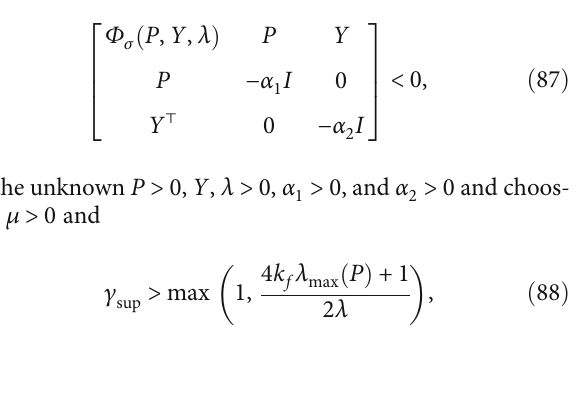
Figure 2: Measurement, state variables, estimates, residuals, and γ ð t Þ for x ð 0 Þ = ð 0,0,0 : 01 Þ and ̂ x ð 0 Þ = ð 1, 1, 1 Þ in a noisy simulation with ð t Þ zero-mean uniform random noise in [-0.1,0.1] and w w 1 and, using γ ð t Þ ≥ γ under condition (70) and j ̂ e j ≤ inf